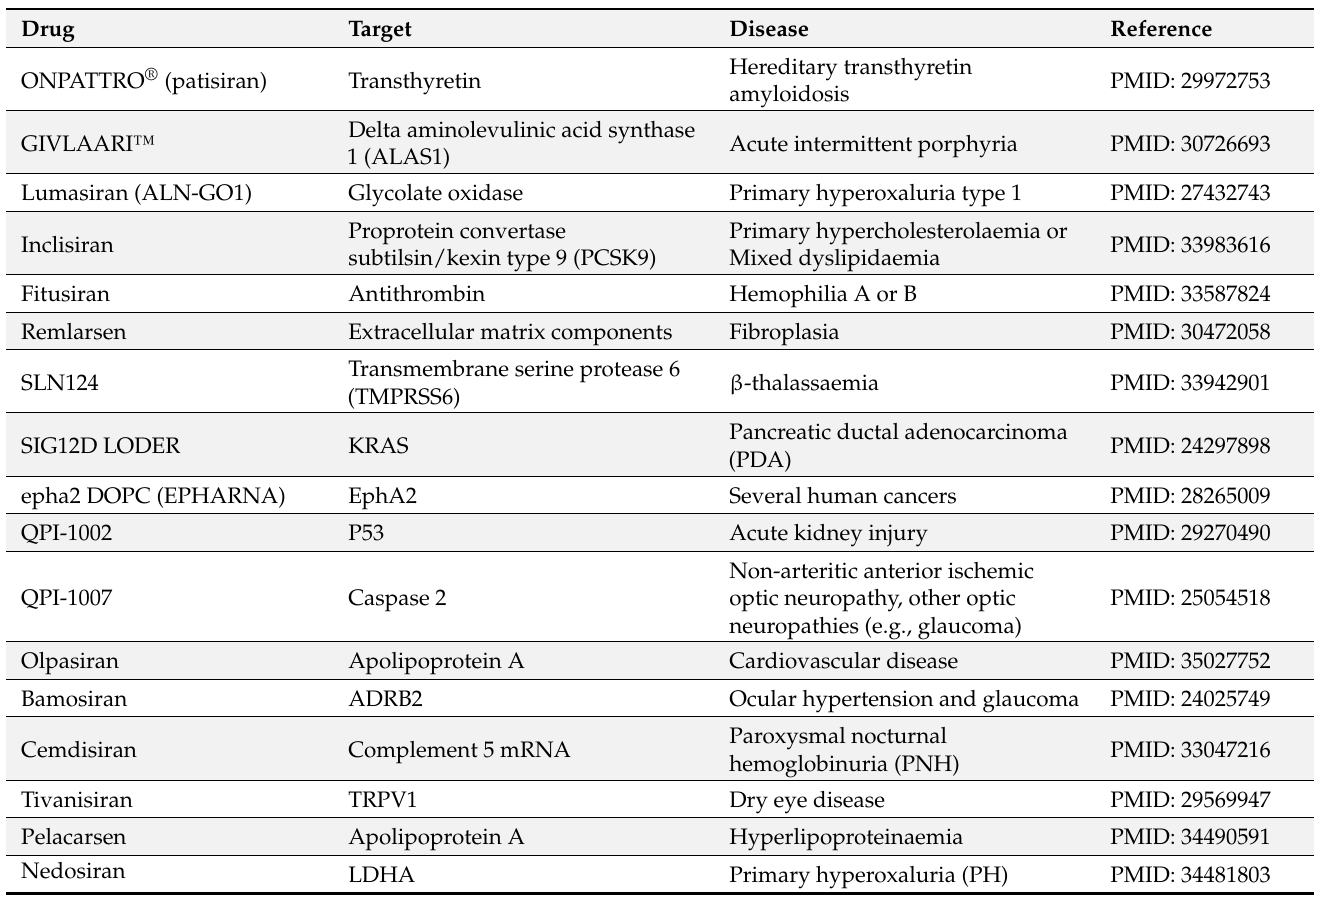
Table 1. List of siRNAs used in therapies or in clinical trials with indicated target gene, disease treated, and reference